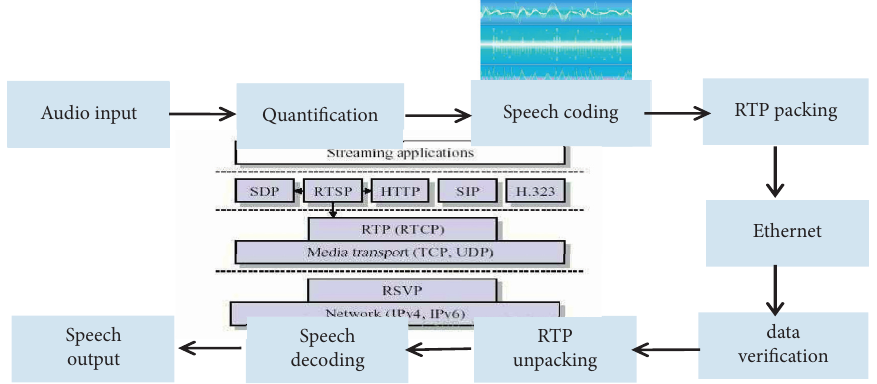
Figure 2: Voice communication flow